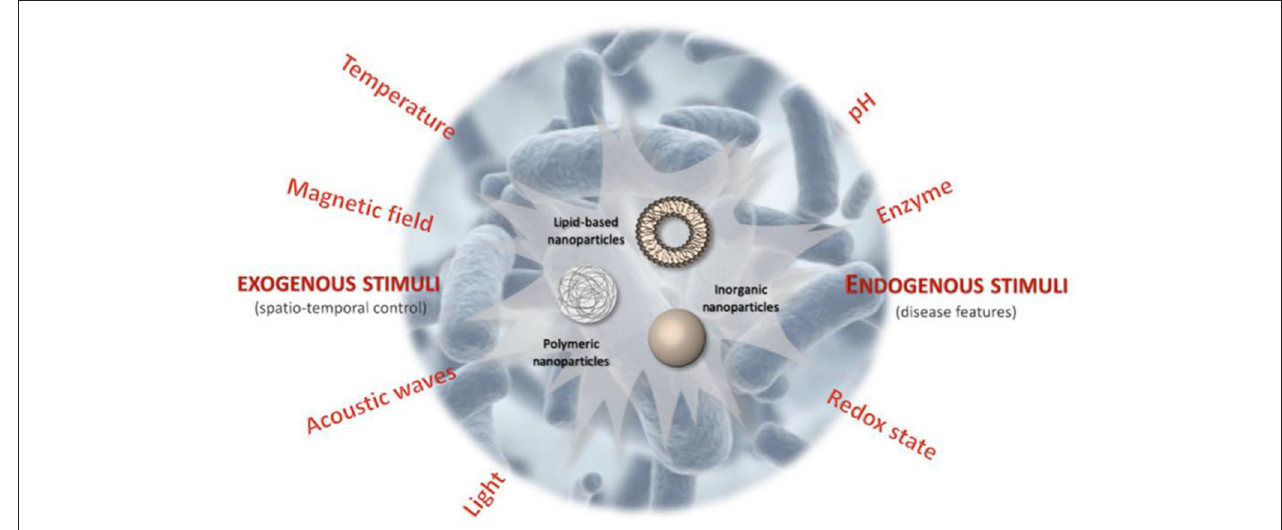
FIGURE 5 | Schematic illustration of stimuli-responsive antibiotic drug delivery systems (Canaparo et al.,